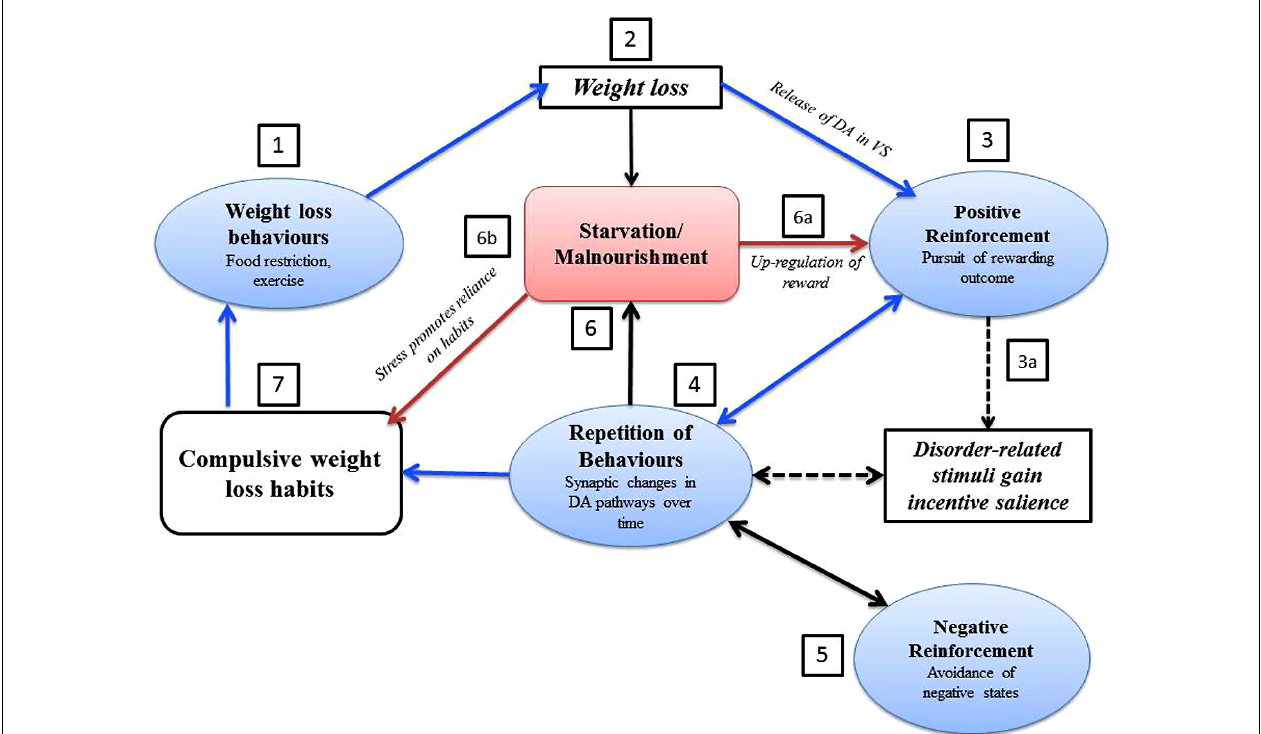
FIGURE 3 |The vicious circle of self-starvation in anorexia nervosa: representation of the development of compulsive weight loss habits in AN. This can be conceptualized as a vicious circle, augmented by starvation. (1) Goal-directed weight loss behaviors, such as food restriction and exercise, lead to weight loss. (2) Weight loss is experienced as rewarding, which may be positively reinforced by an increase of DA in the VS. (3) The pursuit of the rewarding aspects of weight loss leads to a repetition of weight loss behaviors: (a) disorder related cues may gain incentive salience through conditioned reinforcement, and may themselves trigger weight loss behavior (Walsh, 2013). (4) Repetition of rewarding weight loss behavior may result in synaptic changes in DA pathways (Fladung etal., 2013) and result in DA hypofunctioning in a similar way to substance dependence (Everitt and Robbins, 2005). (5) The avoidance of negative states and the anxiety associated with food may become more important in reinforcing weight loss behaviors in the later stages of AN (Selby etal., 2014).